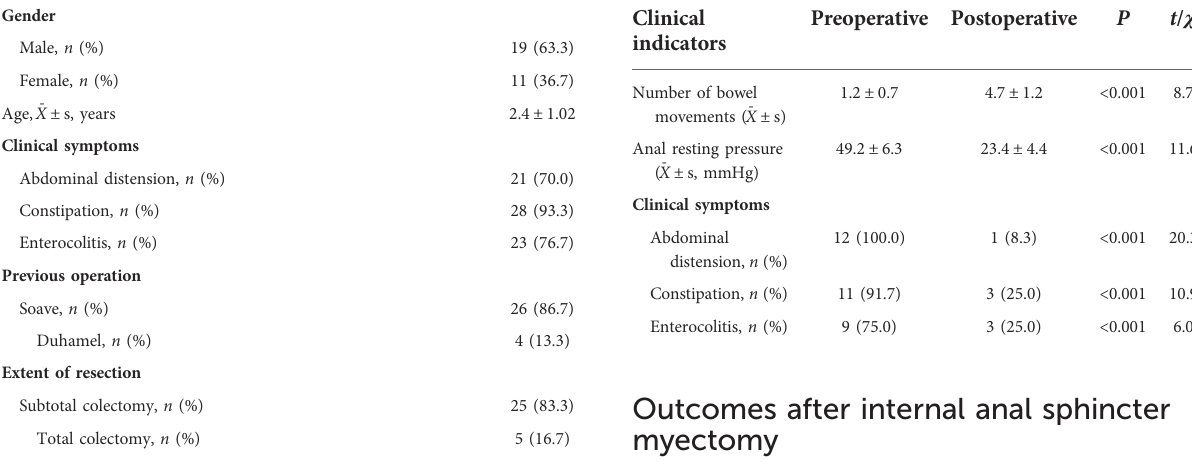
TABLE 3 Outcomes after second botulinum toxin injection ( N =12). TABLE 1 Demographic data and clinical characteristics ( N =30).